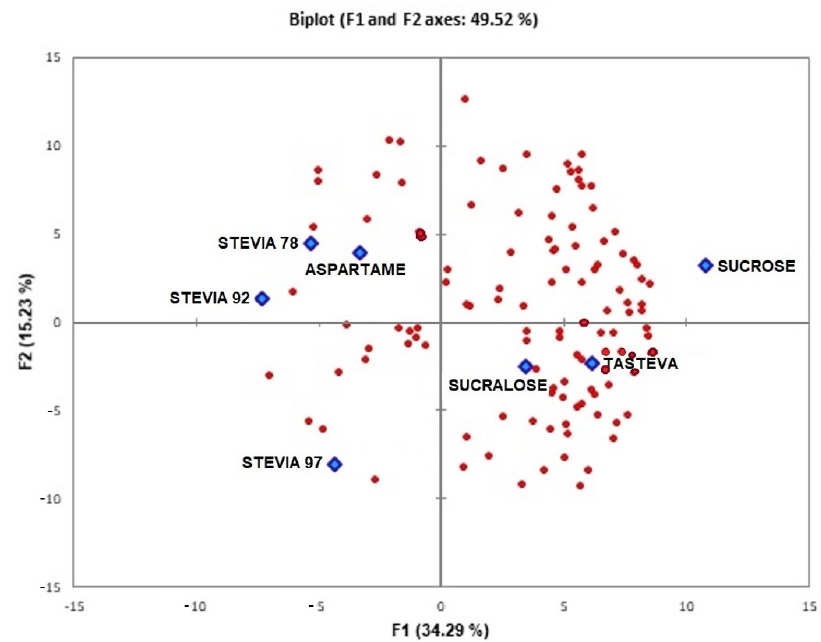
Figure 4. Internal preference map of blackberry nectar referring to the overall impression (Red dots are consumers and blue diamonds are sweeteners used in blueberry nectar).